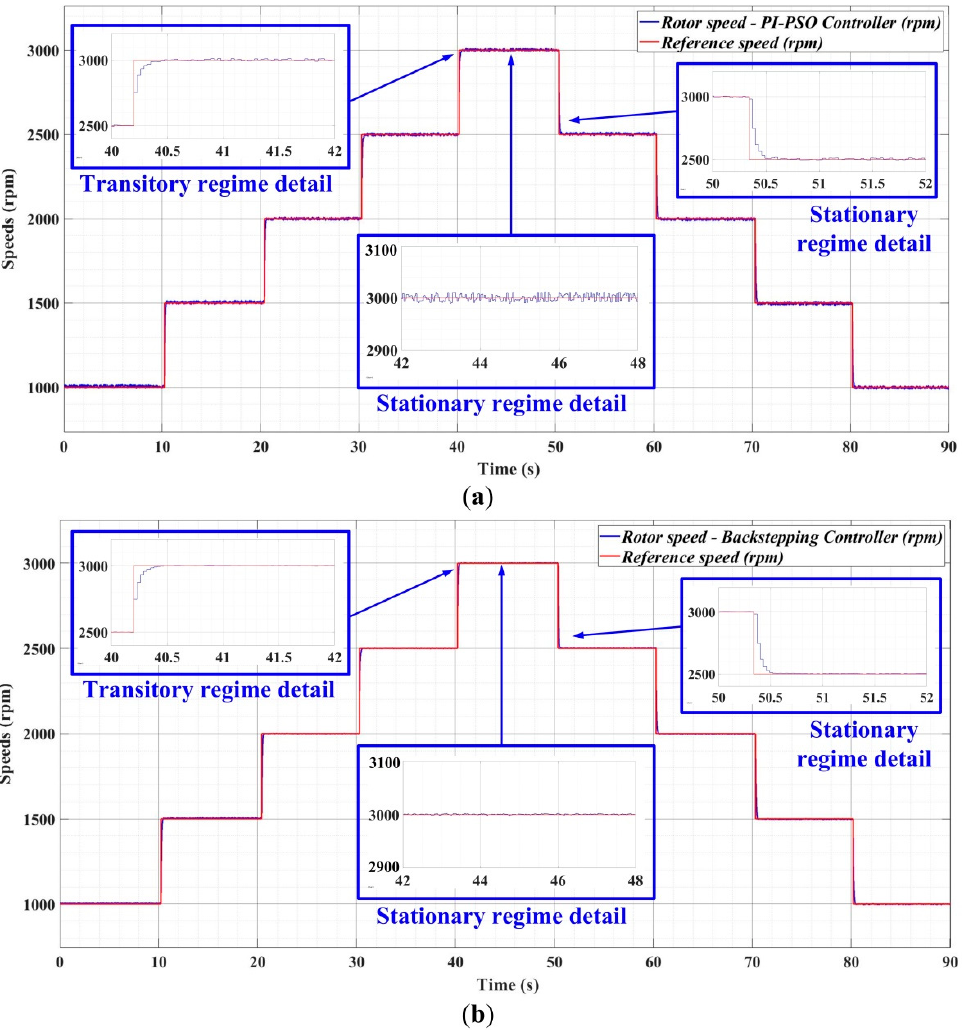
Figure 43. Comparative real-time evolution of the PMSM rotor speeds: ( a ) with PI-PSO controller; ( b ) with backstepping controller.